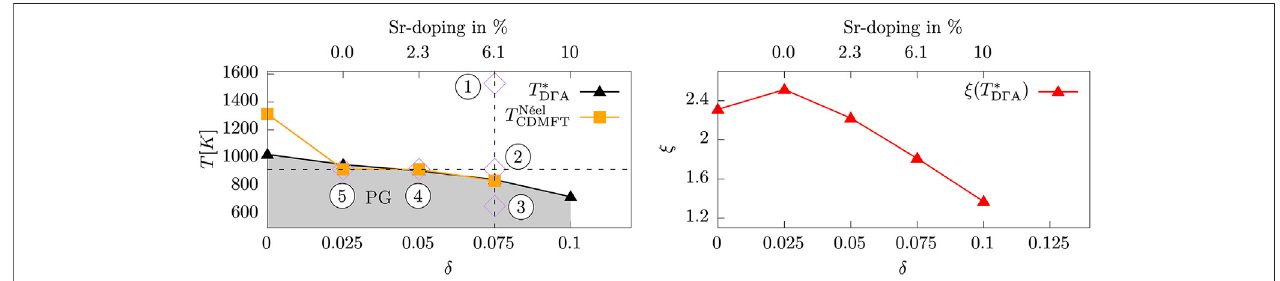
FIGURE1| Left:phasediagramoftheHubbardmodelgivenby Eq.1 asafunctionoftemperature T anddoping δ . T *indicatesthemaximumof χ calculatedinD Γ A (black triangles). The orange squares indicate the magnetic ordering temperature in CDMFT T Néel CDMFT , signalling the onset of non-local correlations. The points — (diamonds) refer to Figures 3 , 4 . Right: The correlation length ξ in units of lattice spacings is shown for the temperatures T